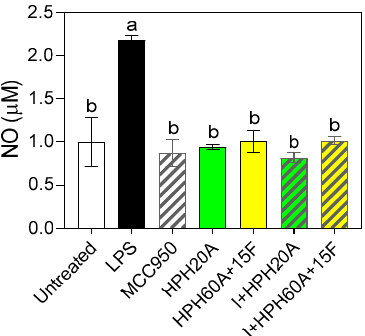
Figure 2. Determination of NO release in BV-2 cells with or without LPS stimulation (1 μ g/mL) and subsequent incubation with MCC950 (I) and HPHs (100 μ g/mL) for 24 h. Values are presented as the means ± SDs ( n = 3); Different letters denote significant differences among the samples. ( p < 0.05).